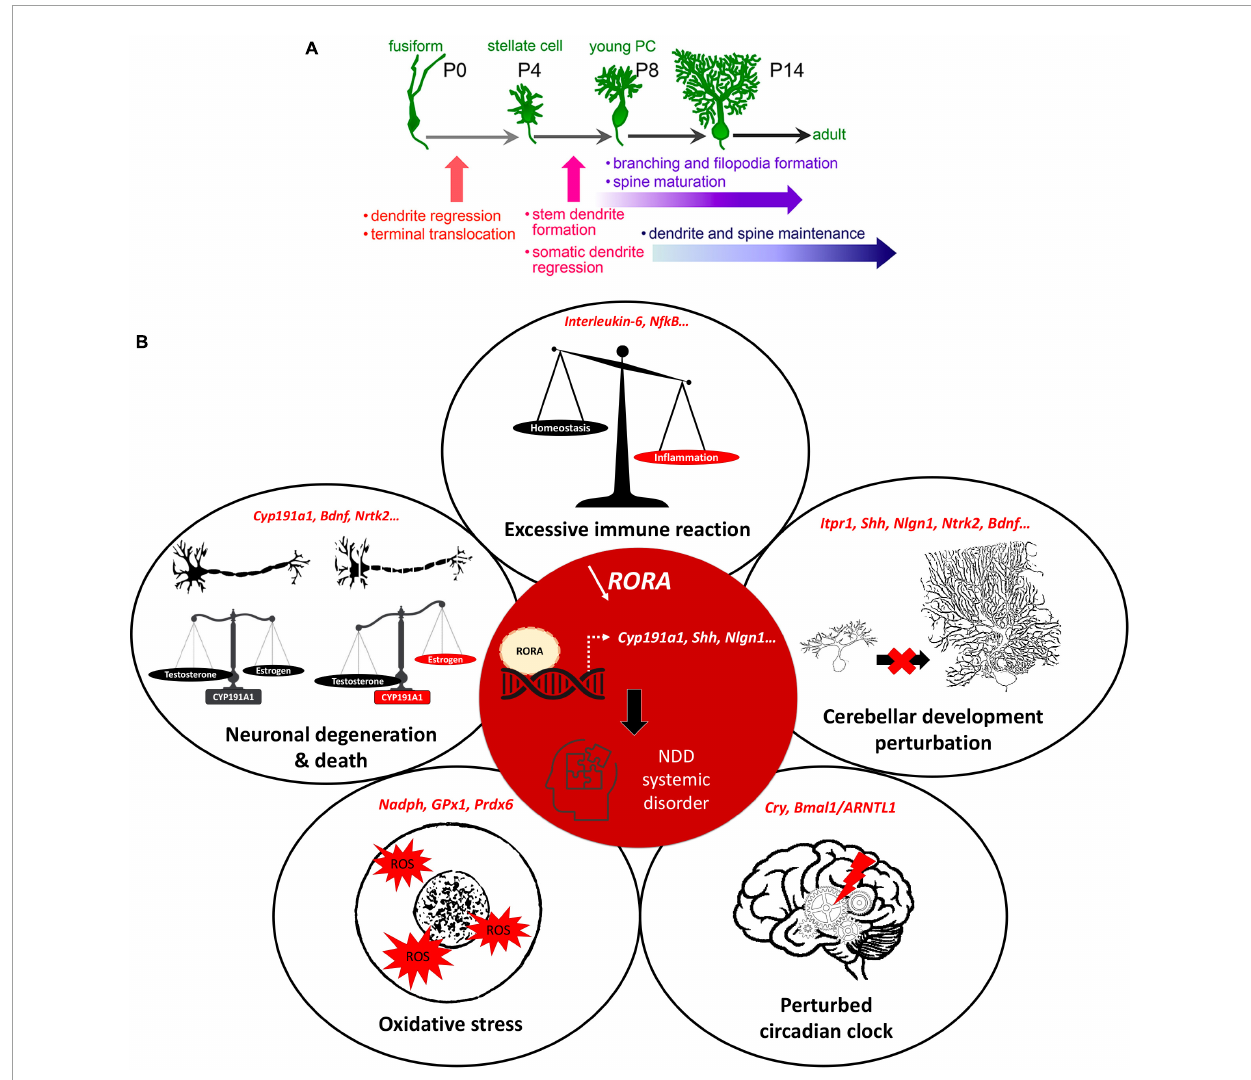
FIGURE2 ROR α regulates multiple genes and plays extensive roles in cerebellar development. (A) Key stages of PC development which are regulated by ROR α . These are at all stages from embryonic development to adult maintenance. Reproduced from Takeo et al. (2015) with permission. (B) A schema showing the central role of ROR α in multiple cellular processes, that are modified in NDDs. When ROR α is reduced (central red circle), its regulation of gene transcription is altered. Here we include the known ROR α target genes that are also involved in NDDs. The effects in red illustrate the induced abnormalities according to the direction of change: estrogen and PC development are reduced, circadian rhythms are perturbed, but inflammation and ROS are